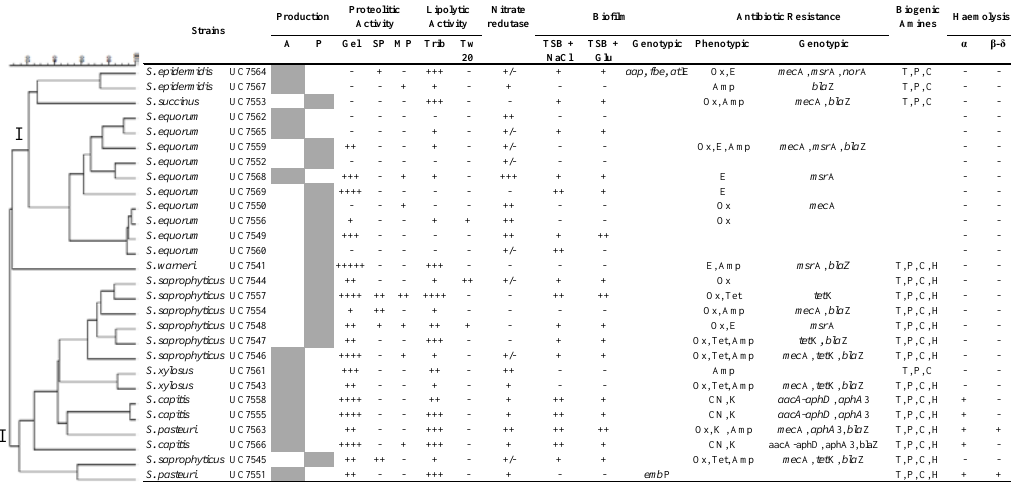
Figure 2. Cluster analysis of the profiles obtained by Random Amplification of Polymorphic DNA (RAPD) from the coagulase-negative staphylococci (CNS) strains isolated from the naturally fermented llama sausages from pilot plant (P) and artisanal (A) productions. Technological, functional and safety properties of isolates are reported in the table: Proteolytic activity (mm): Gelatin (Gel), Sarcoplasmic Proteins (SP); Myofibrillar Proteins (MP): no halo (-). 0.1–1 ( + ); > 1–3 ( ++ ); > 3–5 ( +++ ); > 5 ( ++++ ). Lipolytic activity (mm): Tributyrin agar (Trib); Tween 20 (Tw 20): (-).no halo (-). 0.1–1 ( + ); > 1–3 ( ++ ); > 3–5 ( +++ ). Nitrate reductase negative (-); moderate red ( ± ); evident red ( + ); deep red ( ++ ). Antibiotic Resistance: Ampicillin (Amp); Oxacillin (Ox); Tetracycline (Tet); Gentamicin (CN); Kanamycin (K); Erythromycin (E). Biogenic amines: Histamine (H); Tyramine (T); Putrescine (P); Cadaverine (C). Biofilm: Tryptone Soya Broth (TSB) with 3% NaCl and TSB with 1% Glucose (Glu): negative - (OD 600 < 0.1); moderate + (OD 600 > 0.1– < 1.0) and positive ++ (OD 600 ≥ 1.0). Hemolysis (mm): Tryptone Soy Agar added with horse blood ( α ); Tryptone Soya Agar added with sheep blood ( β - δ ); < 1 negative (-); ≥ 1– < 2 weak ( + ); > 2 high ( ++